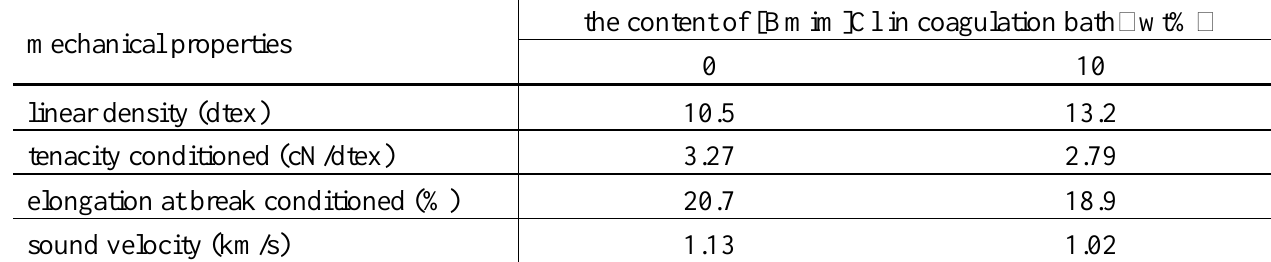
Table 2. Effect of the composition of coagulation bath on Mechanical properties of as-spun fibers .